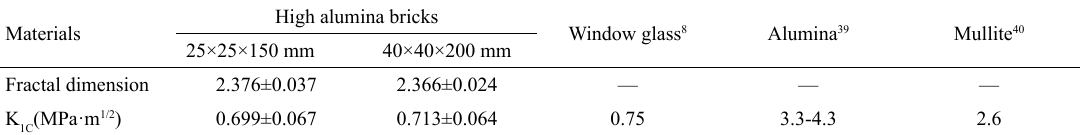
Table 3. Comparison of fractal dimension and fracture toughness for different materials